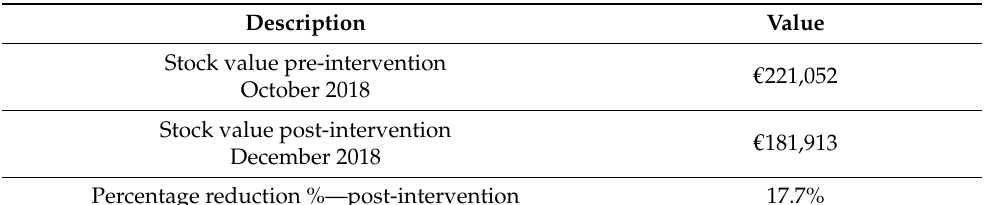
Table 3. Stocktake value in pilot OR pre-and post-intervention.